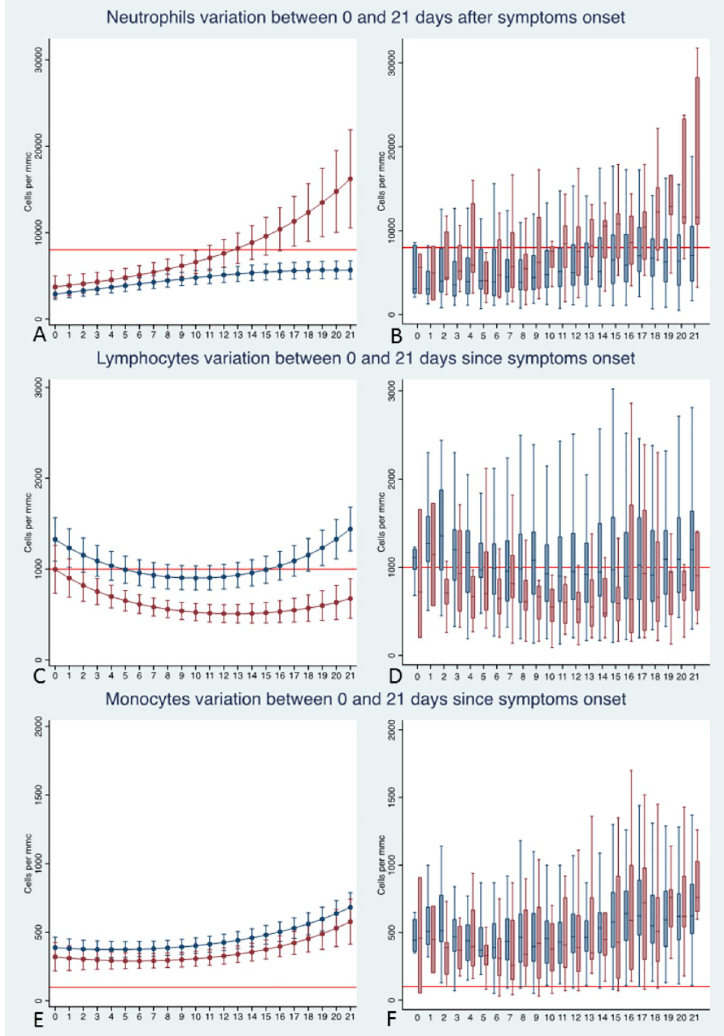
Fig 2. Plots of predicted values and box plots of observed values of average neutrophils (A, B), lymphocytes (C, D) and monocytes (E, F) counts over time for survivors (blue line and boxes) and non-survivors (red line and boxes). In the box plots the outliers are not displayed. All estimates were made on the full dataset, including 1805 determinations on the 379 patients. The red line in plots A and B marks the upper normal limit range of neutrophils (8,000 cells/mmc (red line). The red line in plots C and D marks the lower normal limit of lymphocytes (1,000 cells/mmc). The red line in plot E and F marks the lower upper normal limit of monocytes (100